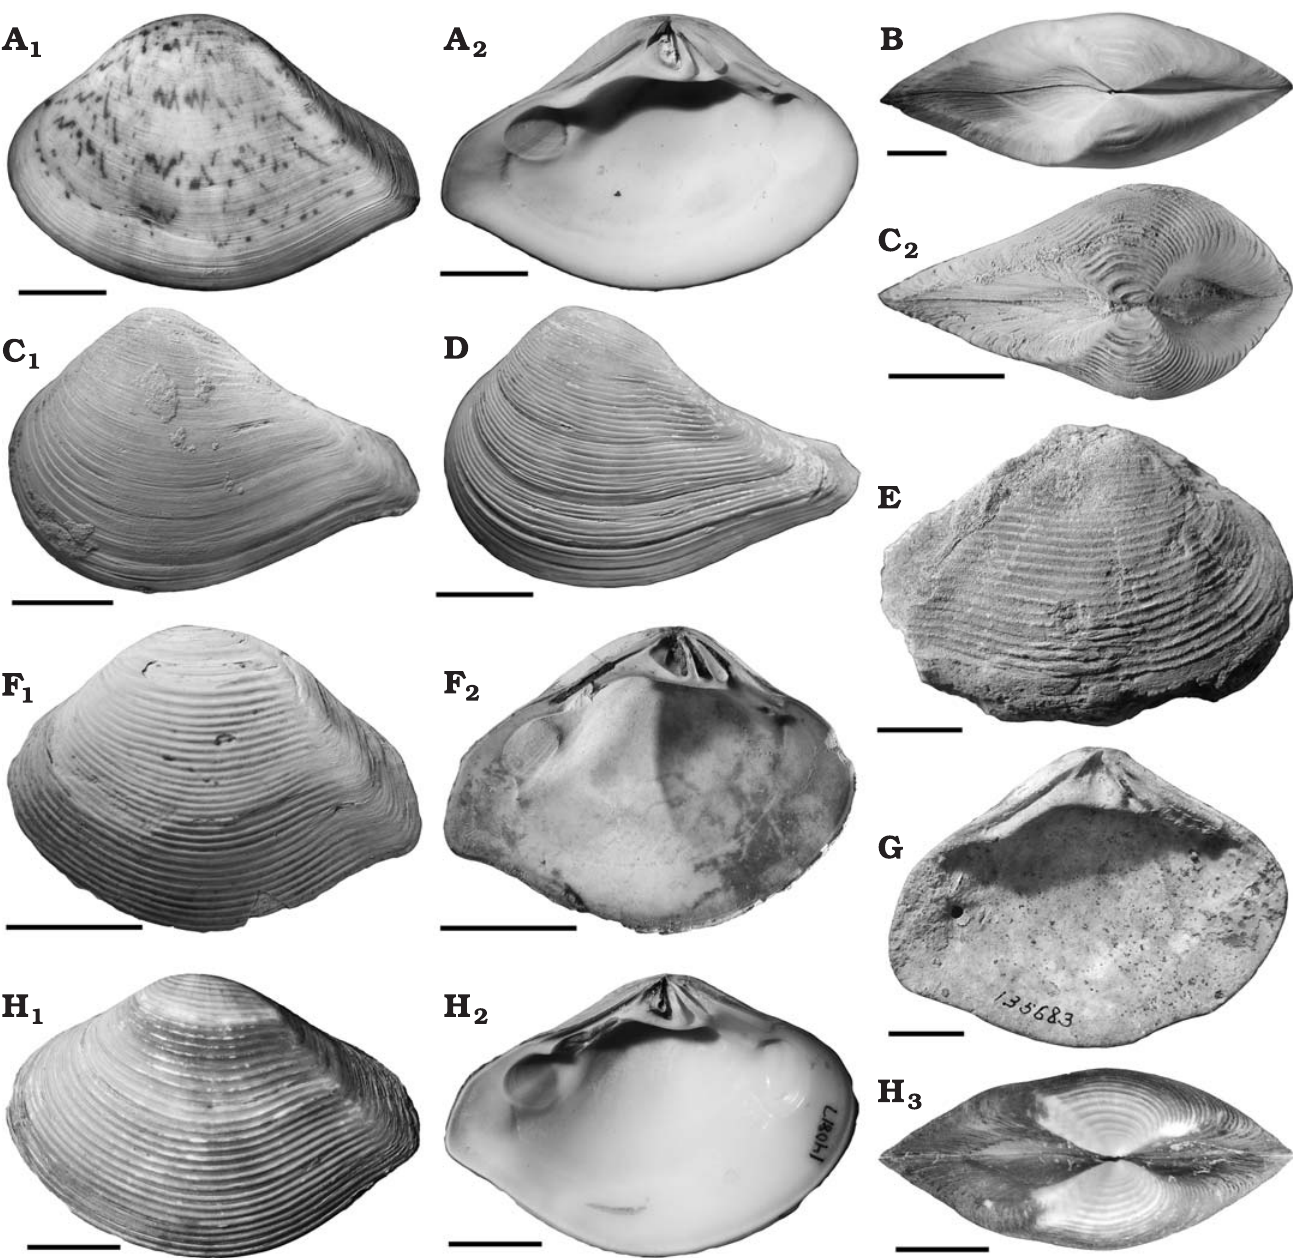
Fig. 3. Crassatelline bivalves from Central and South America. A , B . Kalolophus antillarum (Reeve, 1842). A . UWBM 101885, Recent, Pacific coast of Panama; exterior (A 1 ) and interior (A 2 ) of left valve. B . UWBM 101884, Recent, Venezuela; dorsal view of paired valves, anterior at right. C . Hybolophus berryi (Spieker, 1922), USNM 562399, early Miocene, lower Zorritos Formation, Zorritos, Peru; exterior of left valve (C 1 ), dorsal view of paired valves (C 2 ), anterior at right. D . Hybolophus elassa Woodring, 1982, USNM 647424, late Miocene, Gatun Formation, Panama; exterior of left valve. E . Kalolophus mediamaricanus (Brown and Pilsbry, 1913), USNM 647421, early Miocene, La Boca Formation, Panama; exterior of right valve. F . Kalolophus sp., USNM 647423, late Miocene, middle Gatun Formation, Panama; exterior (F 1 ) and interior (F 2 ) of left valve. G . Kalolophus jamaicensis (Dall, 1903), USNM 135683, Pliocene, Bowden Formation, Jamaica; interior of left valve. H . Kalolophus speciosus (Adams, 1854), SBMNH 140817, Recent, Panama City, Florida; exterior (H 1 ) and interior (H 2 ) of left valve; dorsal view of paired valves (H 3 ), anterior at right. Scale bars 10